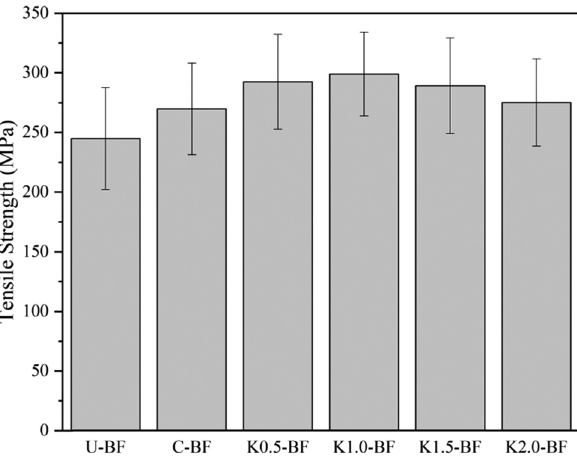
Figure 7: Tensile strength of BF prepregs.